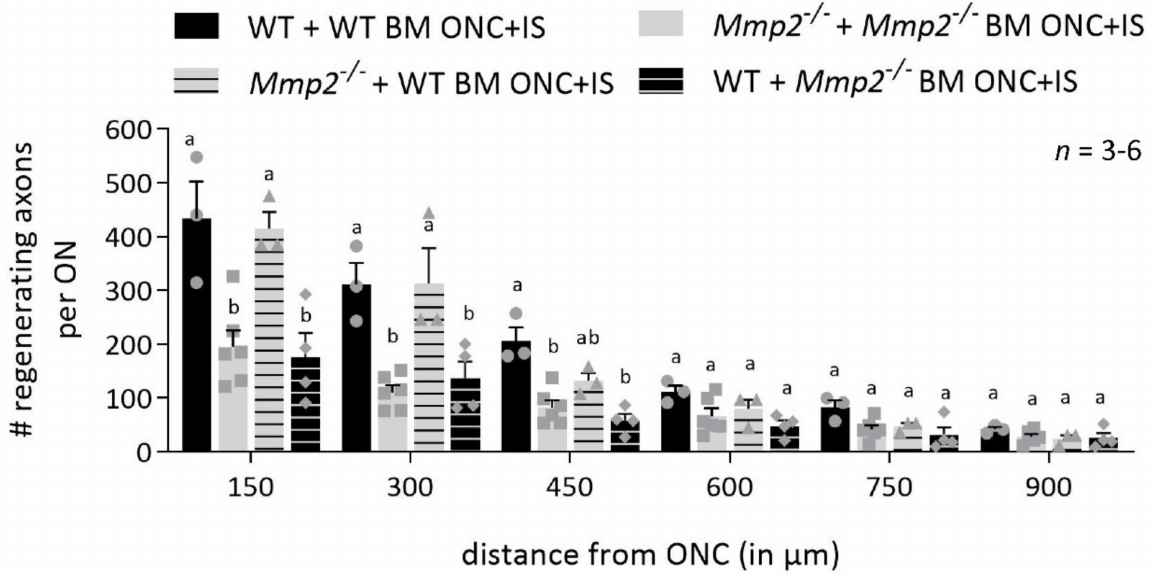
Figure 5. Mmp2 -/- mice transplanted with WT bone marrow show a rescue effect. Graphic of the number of CTB + axons per optic nerve in function of the distance from the ONC site, comparing the number of CTB + axons in WT mice transplanted with WT BM (black), Mmp2 -/- mice with Mmp2 -/- BM (grey), Mmp2 -/- mice with WT BM (grey with black stripes) and WT mice with Mmp2 -/- BM (black with grey stripes) at 14 dpi ONC+IS. The number of CTB + axons was counted every 150 µ m from the ONC site till 900 µ m. At closer distances from the ONC site, there was higher number of CTB + axons in the WT + WT BM mice compared to the Mmp2 -/- + Mmp2 -/- BM mice, confirming data in Figure 1. However, similar numbers of CTB + axons were observed in WT + WT BM mice and Mmp2 -/- + WT BM mice, indicating a rescue effect of WT bone marrow transplanted in Mmp2 -/- mice. Strikingly, the WT+ Mmp2 -/- BM mice show similar numbers of CTB + axons as in Mmp2 -/- + Mmp2 -/- BM animals, suggesting a clear contribution of MMP-2 expressing leukocytes in initiating